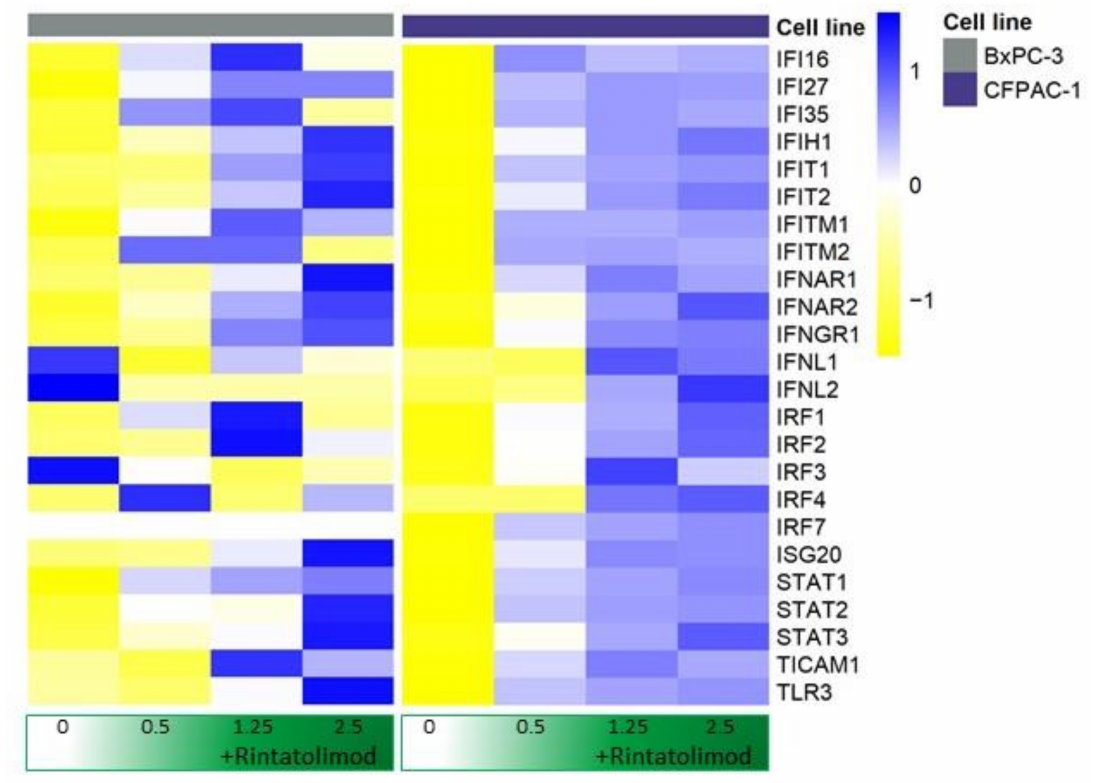
Figure 1. Rintatolimod stimulated interferon production and activated the interferon signaling pathway in HDAC cells. Heat maps of genes involved in the interferon signaling pathway. The linear values of the gene expression were used to generate the heat maps. The expressions were gene-wise scaled and are displayed as colors ranging from blue (high expression) to yellow (low expression) as shown in the key. Cells were treated with various concentrations of Rintatolimod displayed as the intensity of green color from dark green (high dose) to white (PBS